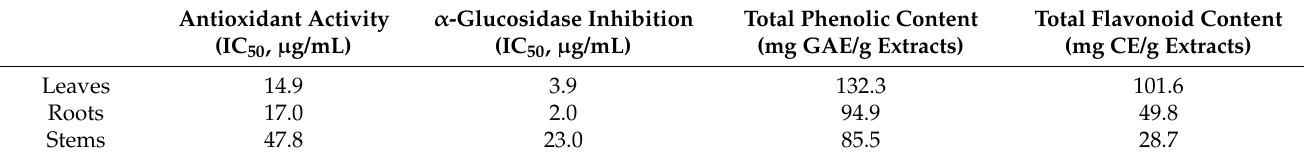
Table 1. Total phenolic and flavonoid content of leaves, roots and stems of C. formosum ssp. pruniflorum .